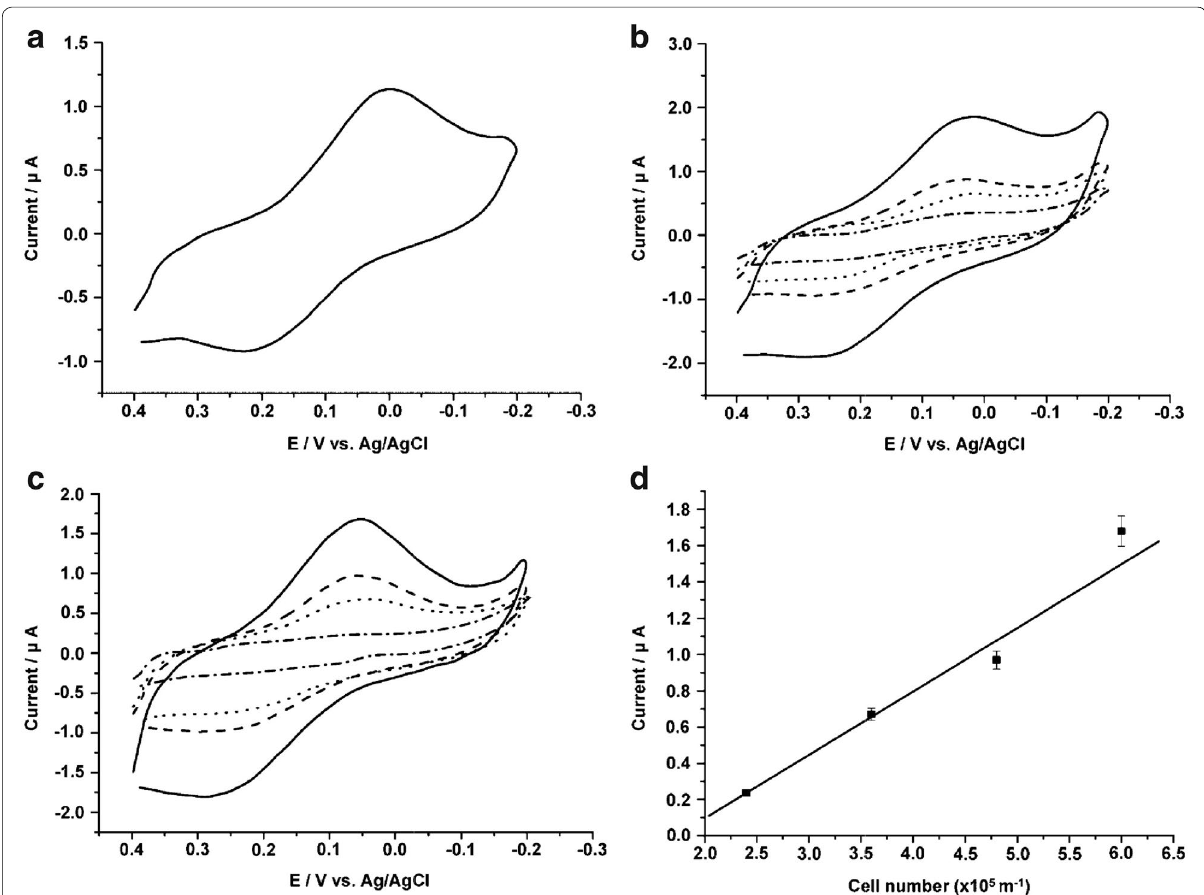
Fig. 2 Electrochemical response ( a ) of HeLa cells using a scan rate of 100 mV s − 1 , temperature of 37 Cyclic voltammograms of HeLa cells at different scan rates (dash dot dash lines) 25 m V s − 1 , (dotted lines) 50 m V s − 1 , (dashed lines) 100 m V s − 1 , (solid lines) 200 m V s − 1 . c Relationship of peak current with the cell number (dashed lines) 2.4 (dashed lines)